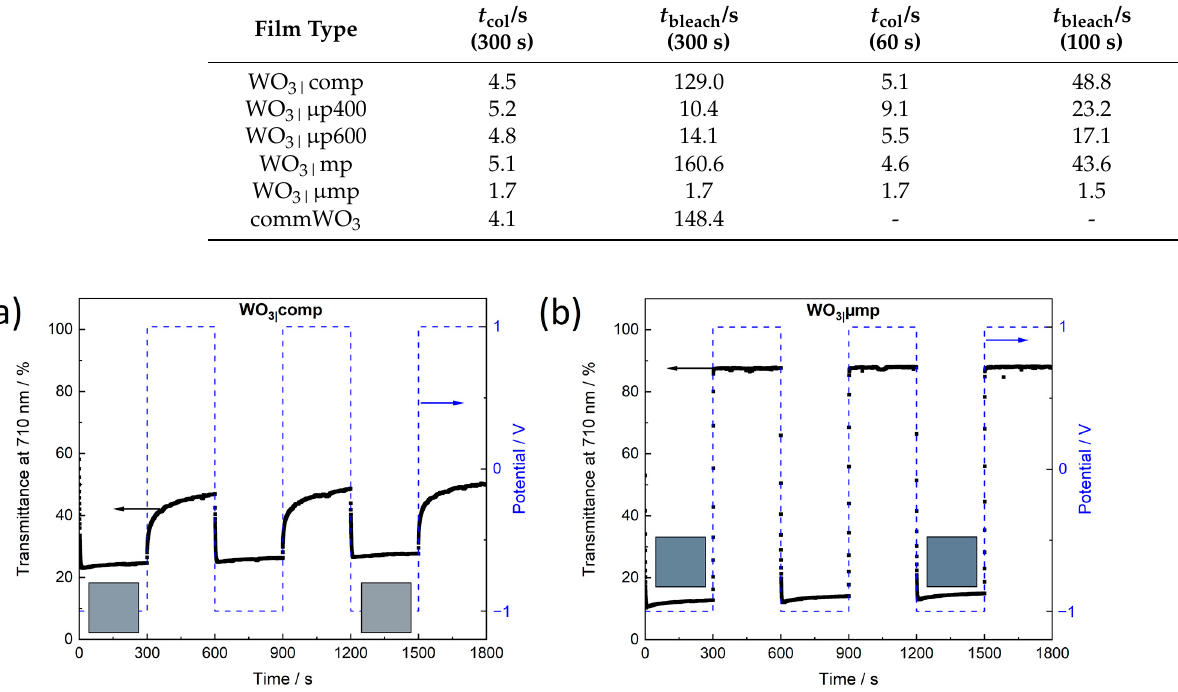
Figure 9. Optical transmittance at 710 nm of ( a ) WO 3| comp and ( b ) WO 3| µmp in LiClO 4 in PC, recorded during chronoamperometry between the potentials depicted as dashed profiles. The insets show the calculated color impressions of the films at the first and the third cycle at the colored states.